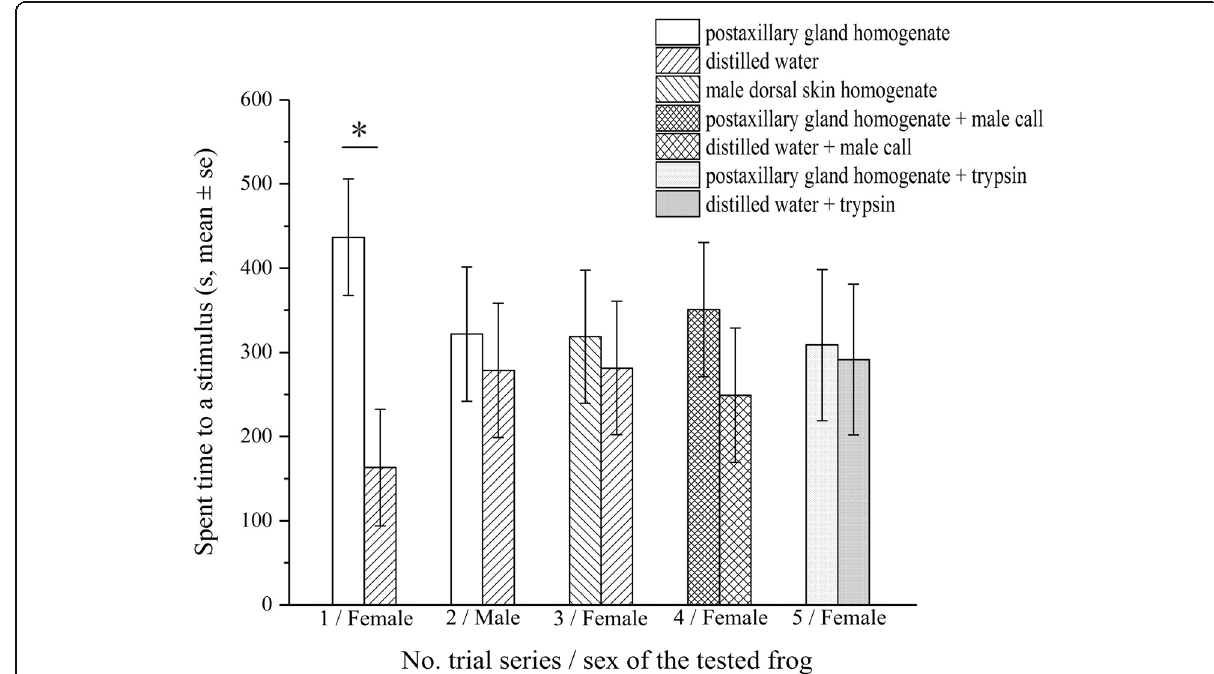
Fig. 5 Results of the five series of animal behavior trials. Note only females show a preference of homogenate of the postaxillary glands over distilled water. Trial series 1, female chooses between homogenate of the postaxillary gland and distilled water; trial series 2, male chooses between homogenate of the postaxillary gland and distilled water; trial series 3, female chooses between homogenate of male dorsal skins and distilled water; trial series 4, female chooses between (homogenate of the postaxillary gland plus male advertisement call) and (distilled water plus male advertisement call); trial series 5, female chooses between trypsin treated homogenate of the postaxillary gland and trypsin treated distilled